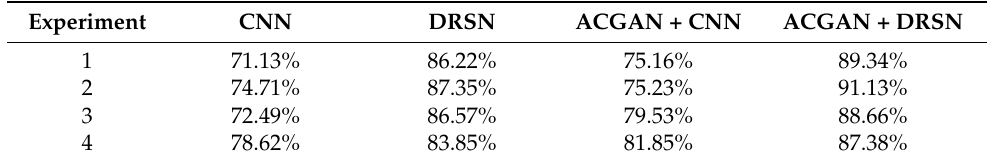
Table 3. Fault classification accuracy under variable working